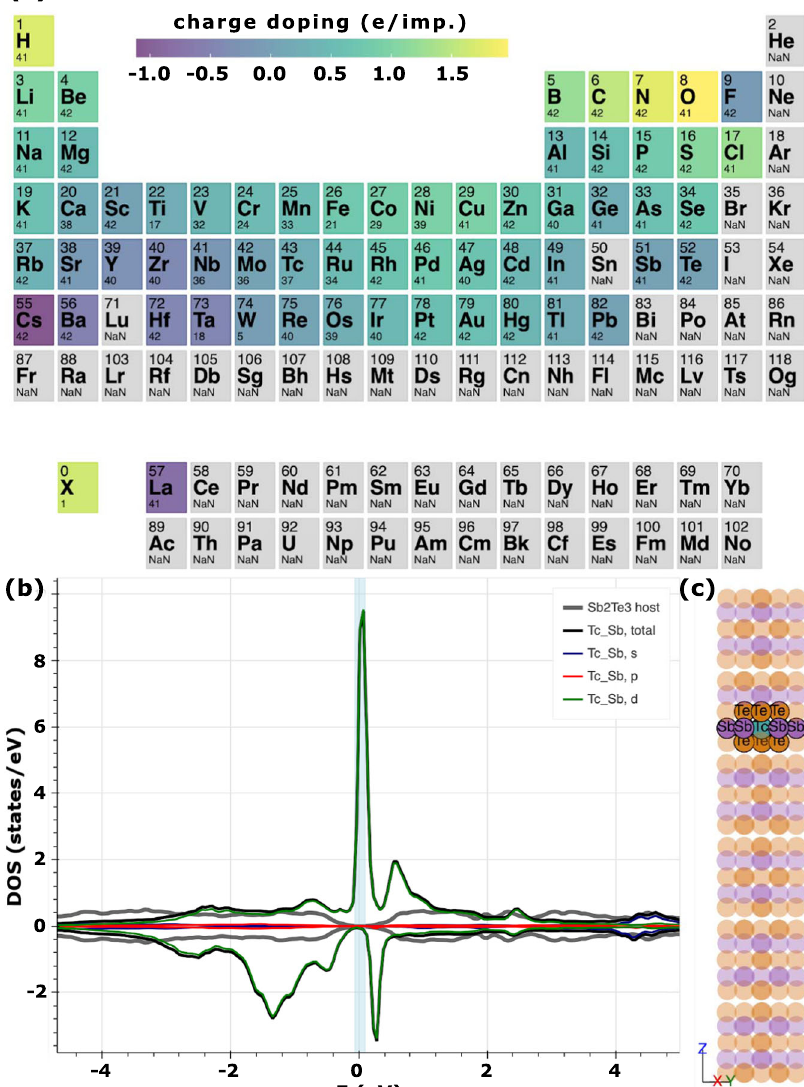
Fig. 7 Impurity properties of defects in Sb 2 Te 3 . a Overview of the impurity-induced charge doping (averaged over all considered impurity con fi gurations, given in electrons per impurity atom). b Impurity density of states for a Tc Sb defect showing a resonance arising in the bulk band gap region (blue shaded region). Positive and negative values correspond to minority and majority states. c Location of the Tc Sb impurity in the Sb 2 Te 3 host crystal. The full-colored spheres represent the atoms in the impurity cluster and the opaque atoms show the rest of the host crystal where Δ V =